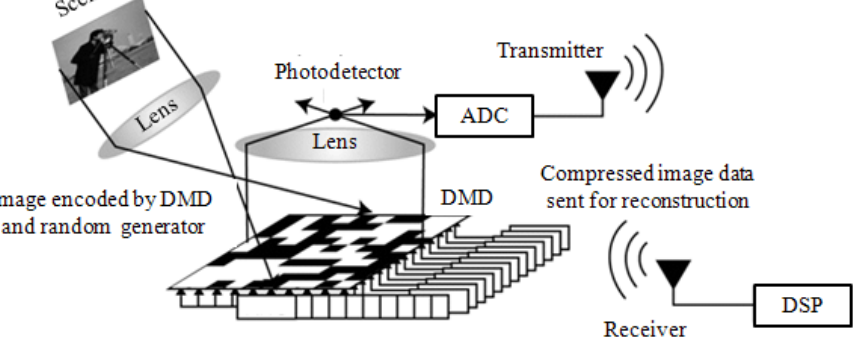
Figure 1. General schematic of single-pixel camera set-up (adapted from [41]) (DMD: digital micro-mirror device; ADC: analog-to-digital converter, DSP: digital signal